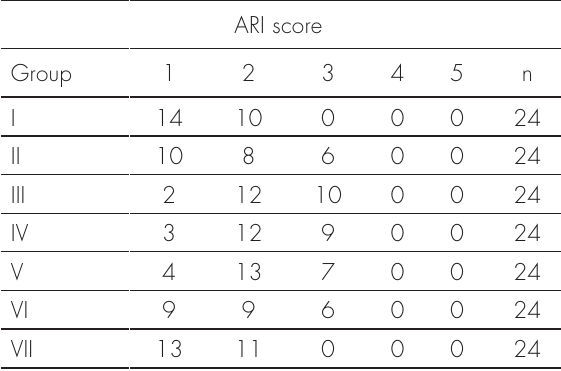
Table IV. Frequency distributions of adhesive remnant index scores. See Table I for group description. ARI